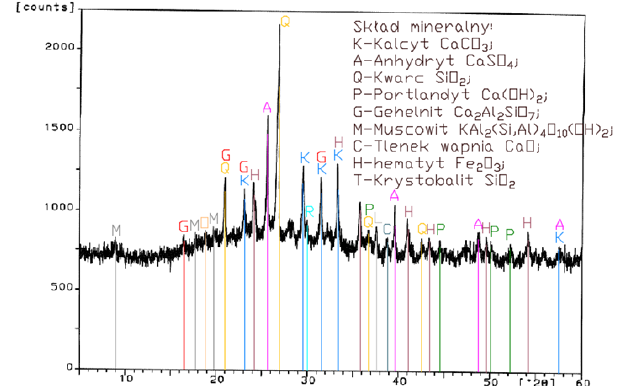
Figure 4. XRD pattern of fluidized bed combustion fly ash from combustion of hard coal (FBC III).